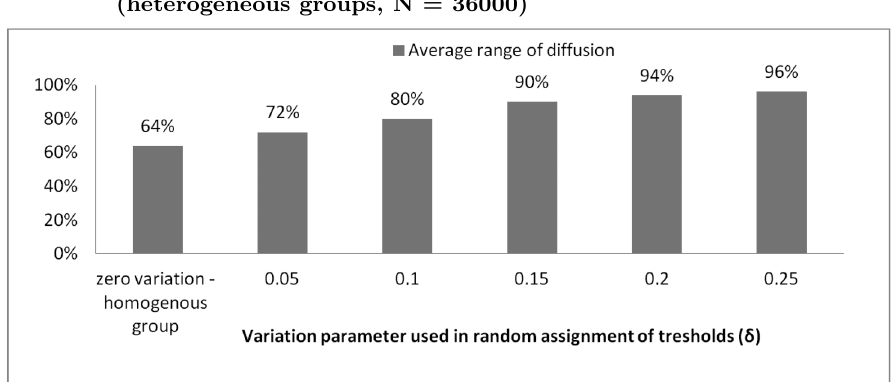
Graph 3. Range of diffusion depending on the variation parameter (heterogeneous groups, N =